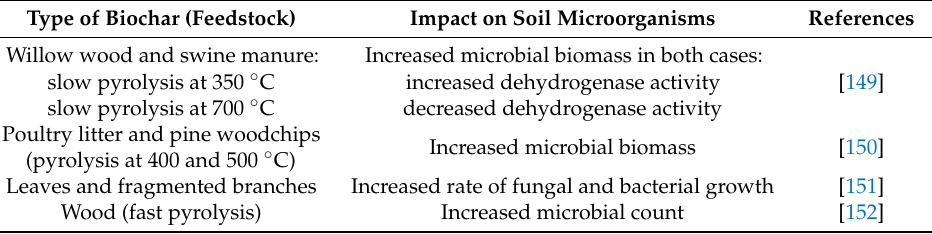
Table 8. Effects of biochar application on the soil environment of soil